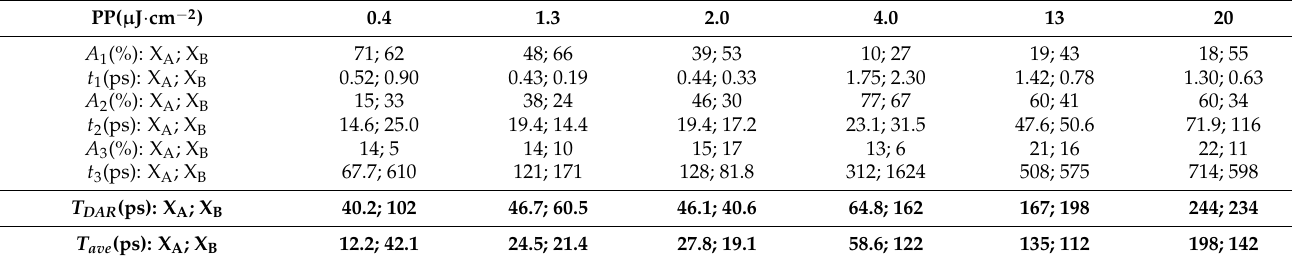
Figure 4. Ultrafast dynamics of exciton depletion signals following excitation at ~3.1 eV (400 nm) with different pump densities. ( a ) Exciton X A depletion averaged around 620 nm in 2D-WS 2 . ( b ) Exciton X B depletion averaged around 510 nm in 2D-WS 2 . ( c ) Exciton X A depletion averaged around 735 nm in 2D-WSe 2 . ( d ) Exciton X B depletion averaged around 595 nm in 2D-WSe 2 . Solid lines are fits to a triexponential decay function convoluted with a Gaussian instrument response function of 45 fs width. The time-delay axes are shown in linear scale up to 1 ps, and logarithmic scale thereafter. Table 1. List of the fit parameters for the depletion recovery signal of excitons X A and X B , upon excitation of the 2D-WS 2 monolayer at ~3.1 eV with different densities. A i and t i are the amplitudes and time constants of the exponential component i . The amplitude-weighted average depletion recovery times T ave are calculated as ∑ i A i t i , and T DAR are calculated as + A + A ( A ) / ( A ) . 2 t 2 3 t 3 2 3